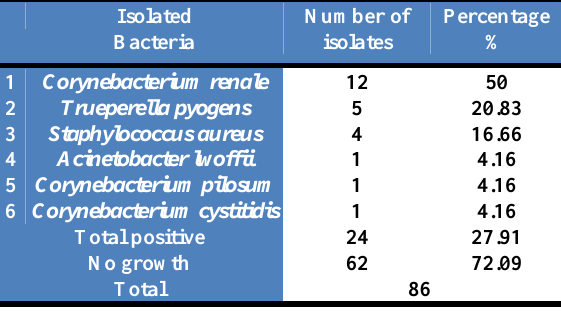
Table, 5: Number and percentage of isolated pathogens from urine of slaughtered buffaloes.